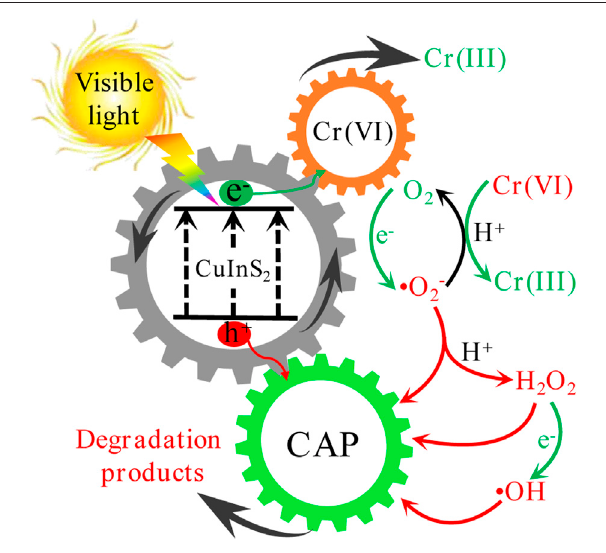
FIGURE 10 | Possible mechanisms of concurrent photocatalytic Cr(VI) reduction and CAP degradation over CuInS 2 under visible-light